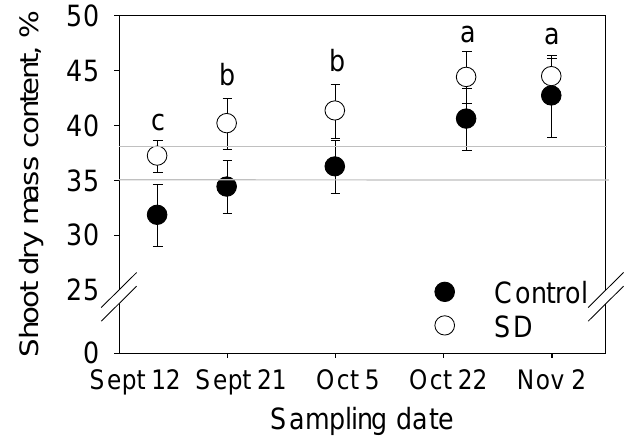
Figure 3. Development of shoot dry matter content (DMC) in 1.5 year old Norway spruce seedlings that received a short-day (SD) treatment or that were grown under a natural photoperiod (control). Values are means of ten seedlings per treatment ± standard deviation. The data were subjected to a linear mixed model (MIXED) procedure. Letters indicate di ff erences between the sampling dates ( p < 0.05). Gray lines indicate the target values for DMC indicating storability of one year old Norway spruce seedlings (35–38%) according to Rosvall-Åhnebrink (1985) [20]. The FH of the needles, stems, and buds was generally better in the SD seedlings than in the control seedlings, although this di ff erence was not statistically significant for every exposure date (Table